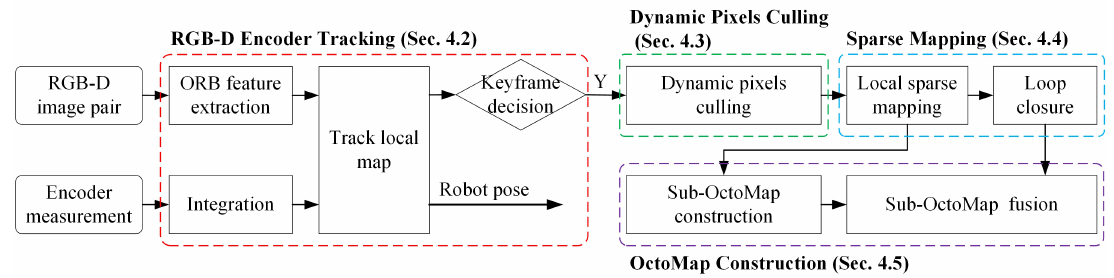
Figure 2. Pipeline of the proposed